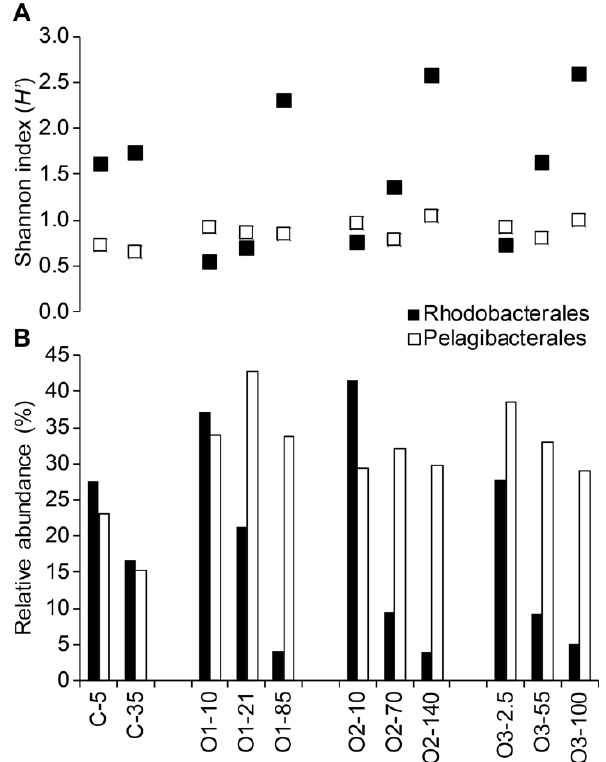
Figure 5. Proteobacterial sequence representation within the bacterial communities. The proportions of sequences from each class are calculated with respect to the total number of sequences obtained for each sample.